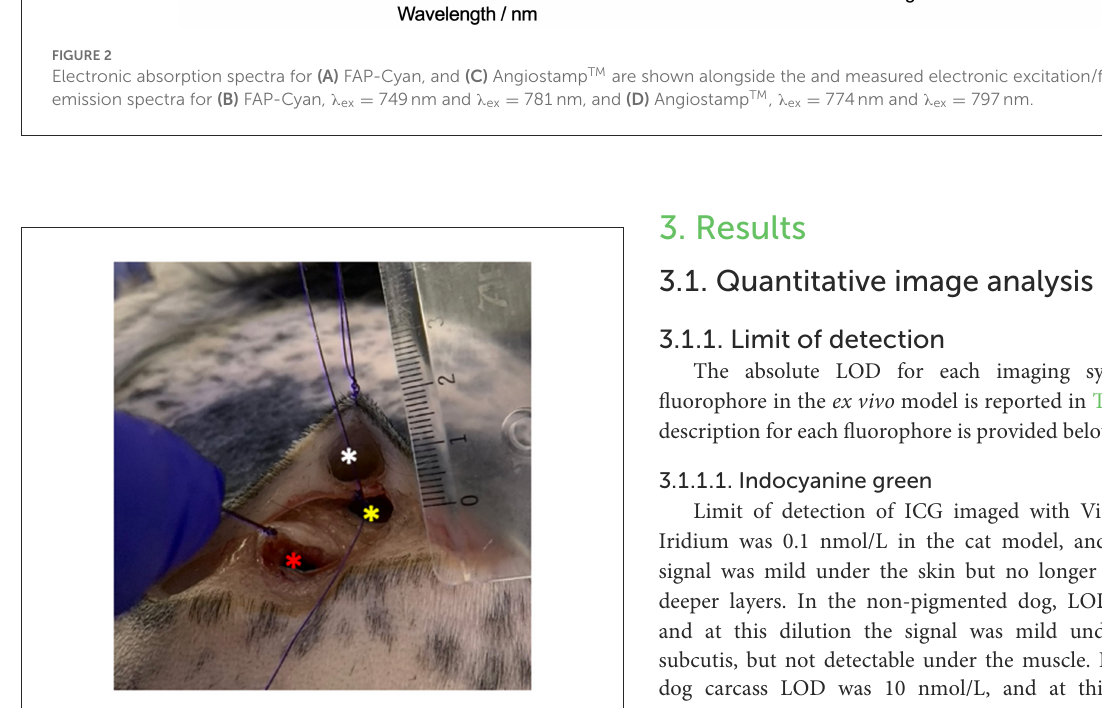
FIGURE3 Tissue pouches on the lateral thoracic wall of the dog carcass. White asterisk: superficial pouch created right under the dermis; yellow asterisk: middle pouch created under the subcutaneous fascia; red asterisk: deep pouch created under the latissimus dorsi muscle. The pouches were all no more than 2cm